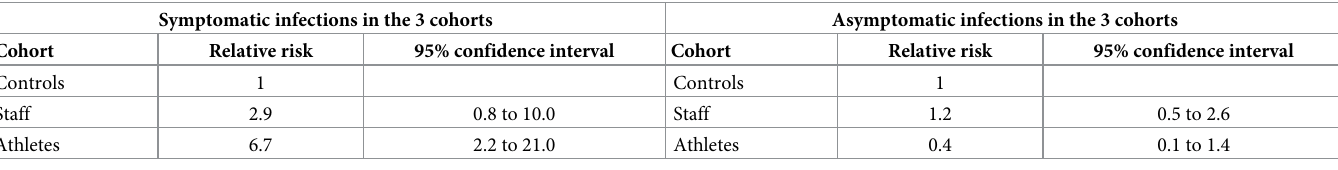
Table 3. Relative risks of symptomatic and asymptomatic infections in the 3 cohorts. Symptomatic infections in the 3 cohorts